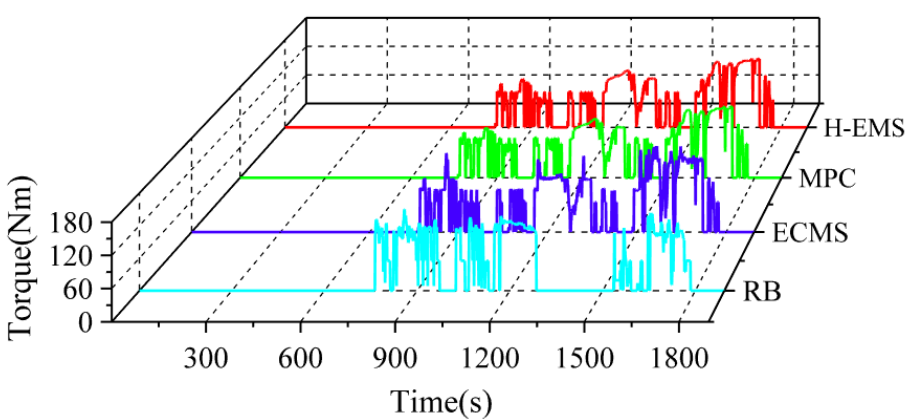
Figure 12. Engine torque of energy management strategies.